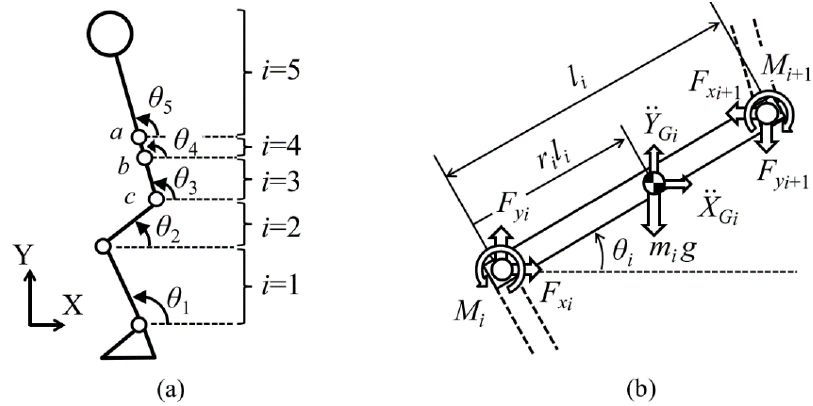
Figure 17. Five-links biomechanical model ( a ) and free body diagram ( b ) of the method proposed by [76]. The inclination angle of each segment is defined on the sagittal plane and the internal forces and moments are represented on the free body diagram.